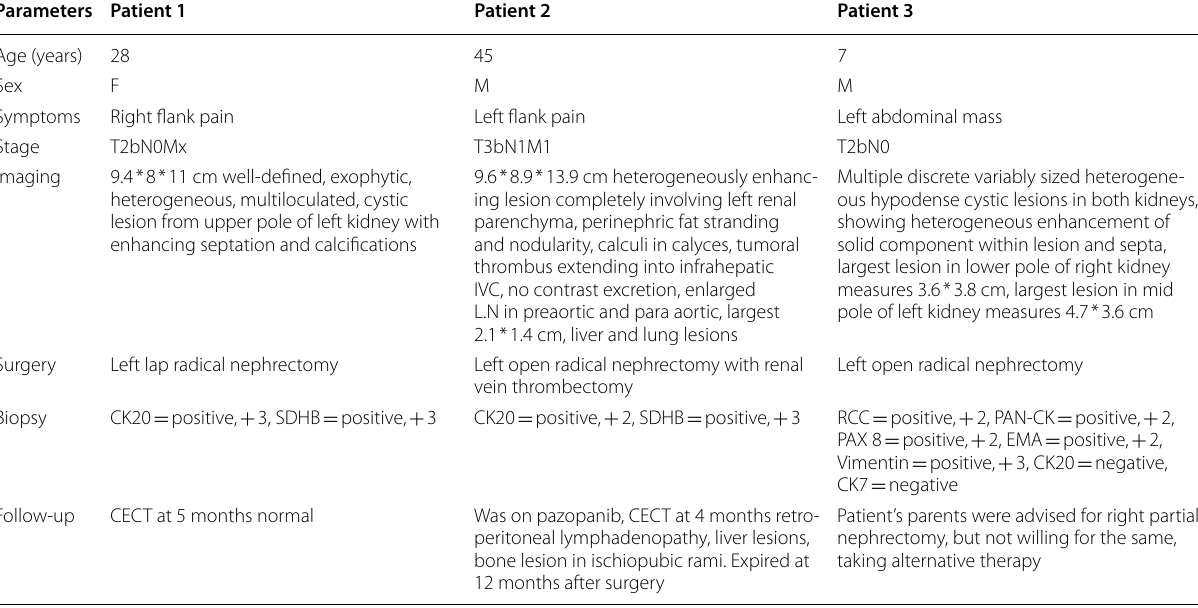
Table 1 Patient demographic details, imaging features, histopathological features and follow-up details Parameters Patient